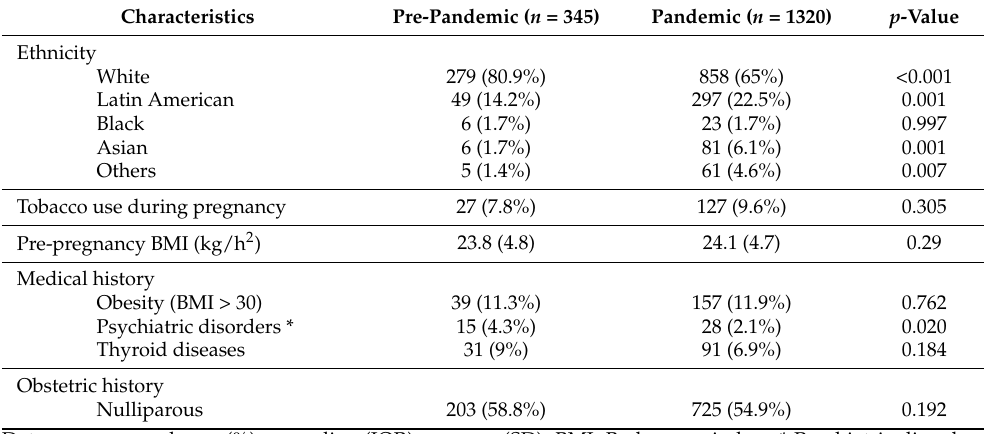
Table A1. Baseline characteristics of pre-pandemic and COVID-19 pandemic pregnant women cohorts.